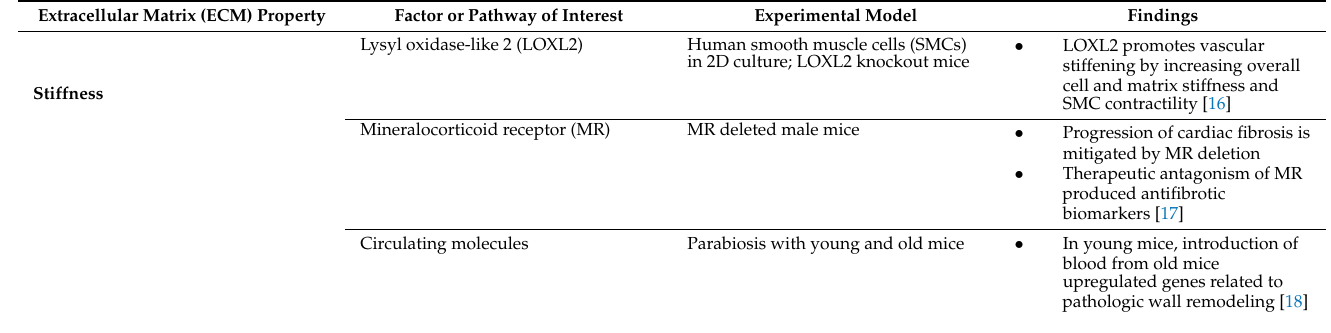
Table 1. Summary of recent studies covering ECM factors involved in SMC behavior regulation. Extracellular Matrix (ECM)